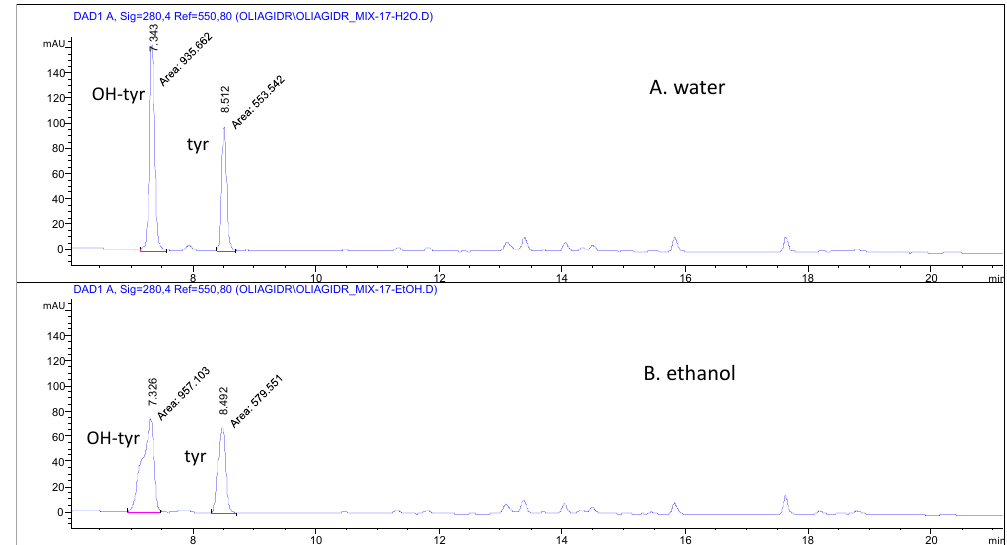
Figure 1. HPLC-DAD profiles at 280 nm of the MIX-17 oil sample after hydrolysis: ( A ), the hydrolysis was quenched using water; ( B ), the hydrolysis was quenched using ethanol.